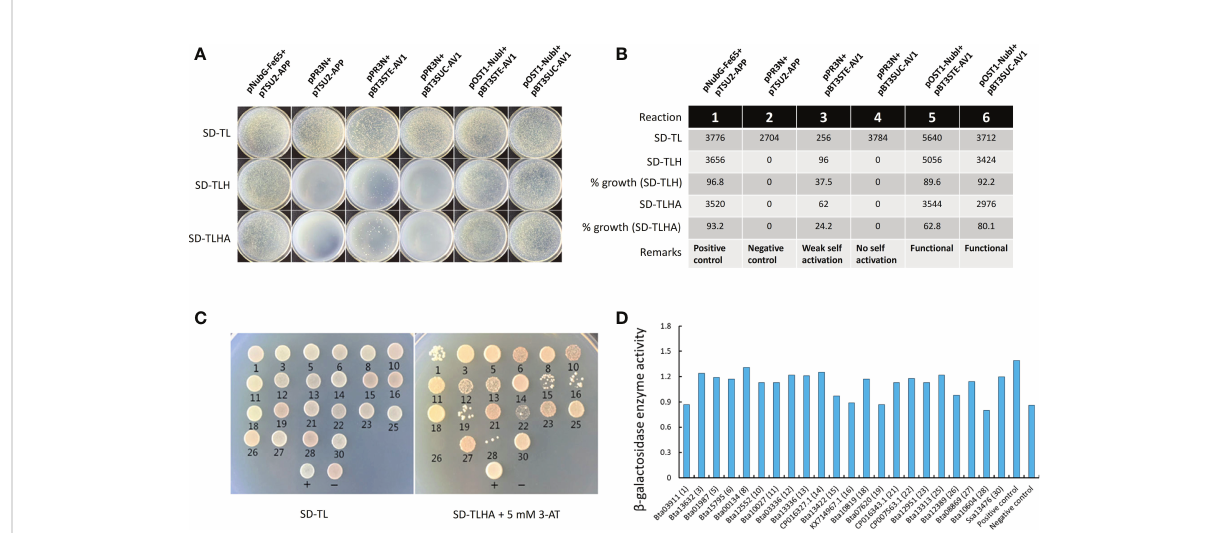
FIGURE 1 Bait self-activation test and functional analysis and interactions between Asia II 7 proteins and CLCuMuV-AV1. (A) Different combinations of plasmids fused with activation or binding domains (AD/BD) were transformed to yeast cells (NMY51) and their growth was monitored on the screening plates containing synthetic de fi ned (SD) media lacking Trp and Leu (SD-TL) and Trp , Leu and His (SD-TLH) and Trp , Leu , His and Ade (SD-TLHA). (B) The number of transformants and percentage growth of plasmids on the selective media. Data represents the growth percentage of co-transformed plasmids used as positive control (1), negative control (2), to test self-activation (3-4) and functional activity (5-6). (C) Validation of interactions between CLCuMuV-AV1 and 21 Asia II 7 proteins as indicated by the growth of co-transformed yeast cells on synthetic de fi ned media lacking Trp , Leu , His and Ade (SD-TLHA) supplemented with 5 mM 3-amintotrizole (3AT) as a result of Ade and His3 genes activation. Plasmid combination pNubG-Fe65 +